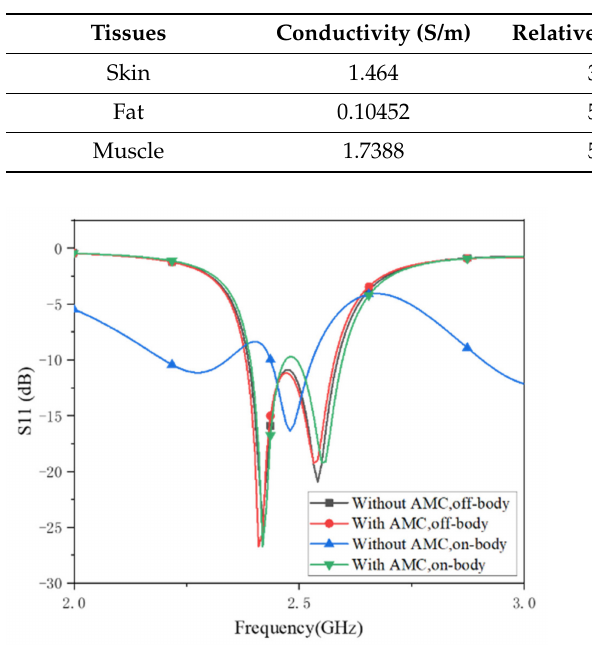
Figure 11. The human tissue simulation model. Table 2. Properties of human tissue at 2.45 GHz.